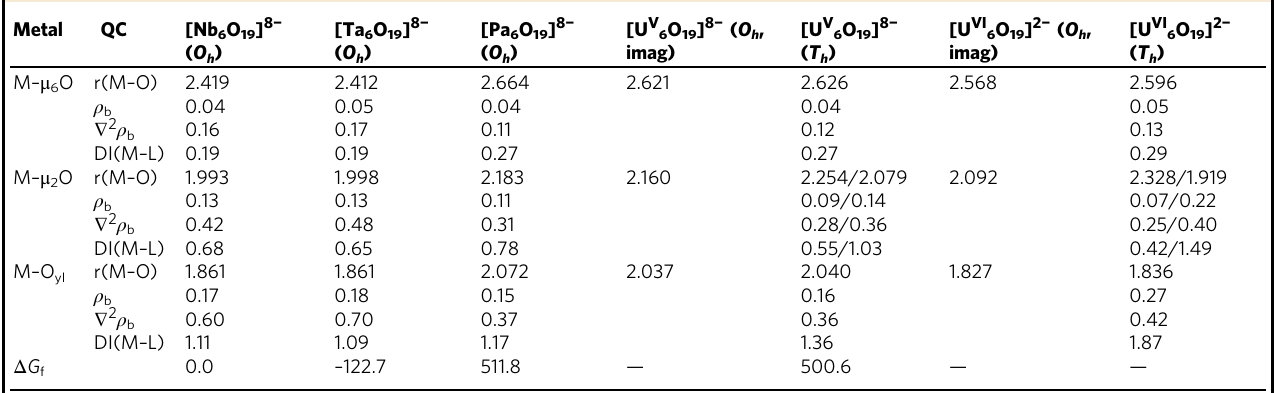
Bond distancesinÅ; electrondensityat thebond criticalpoint,e – bohr – 3 ; theLaplacianat thebond criticalpoint,e – bohr – 5 ;and thedelocalizationindexareshown. Formationfreeenergiescomputedin a water solvent in kJmol − 1 Δ G f of [M 6 O 19 ] 8 − clusters according to the reaction: 6MCl 5 +38OH − → [M 6 O 19 ] 8 − +30Cl − +19H 2 O relative to